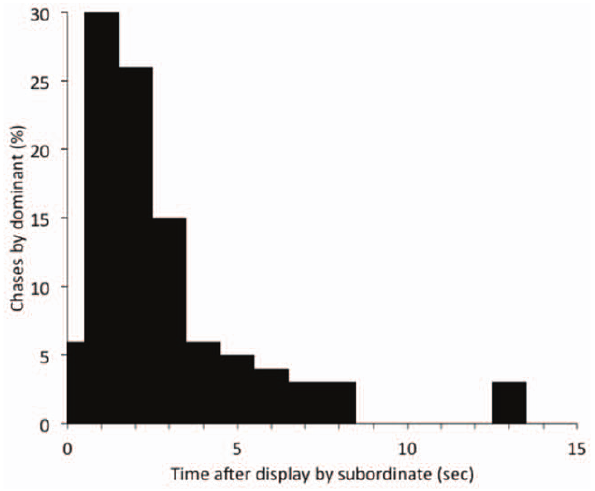
Figure 2. Aggression displayed while dominant male present and absent. Comparison of the number of agonistic, courtship and submissive behaviors performed by subordinates as a function of dominant male presence vs. absence. Chases directed against males (t= 2 6.617, p=0.007) and females (t= 2 4.098, p=0.033) as well as fleeing (t=8.397, p=0.004) were significantly different.